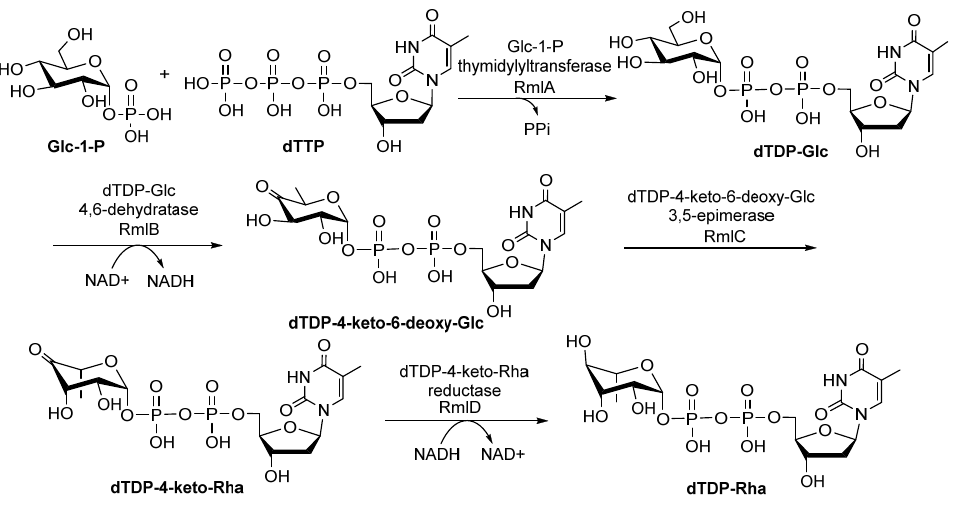
Figure 1. The biosynthetic pathway of dTDP-Rha from Glc-1-P in bacteria [22,23]. RmlA is a nucleotidyltransferase that catalyzes the first reaction to form dTDP-glucose (dTDP-Glc) by transferring a deoxythymidine triphosphate (dTTP) to glucose-1-phosphate (Glc-1-P) via a single sequential displacement mechanism [24]. Based on the reverse reaction, RmlA is also known to be a pyrophosphorylase [24]. RmlA has attracted